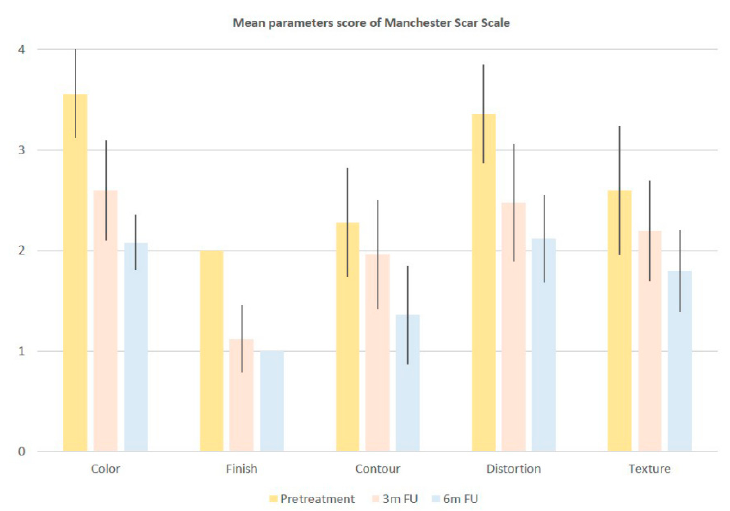
Figure 2. Histogram representation of the mean total score of Manchester Scar Scale.